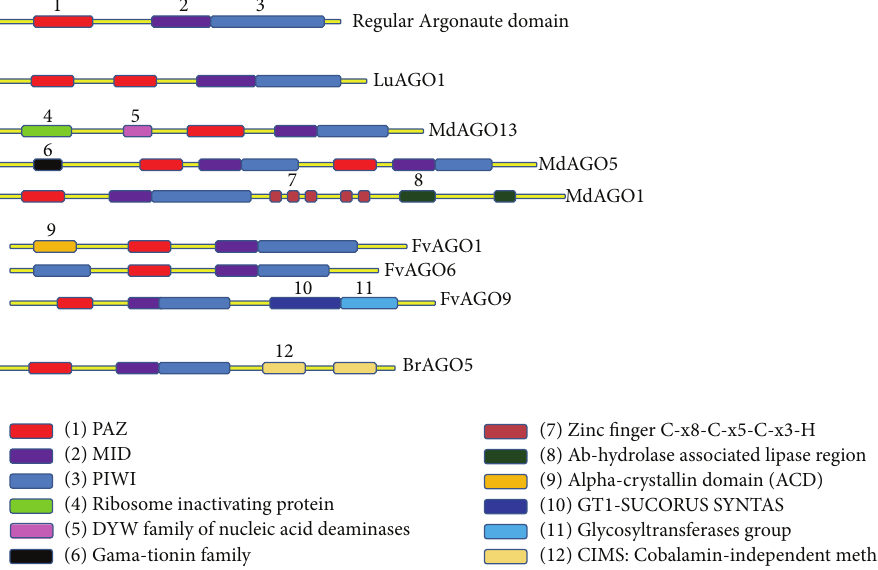
Figure 5: Domain architecture variations in plant Argonautes. The protein domains were obtained using the Conserved Domains Database (CDD) database of NCBI. The Argonaute protein regular domains domains PAZ (red), MID (violet) and PIWI (blue) are shown in addition to other unregular